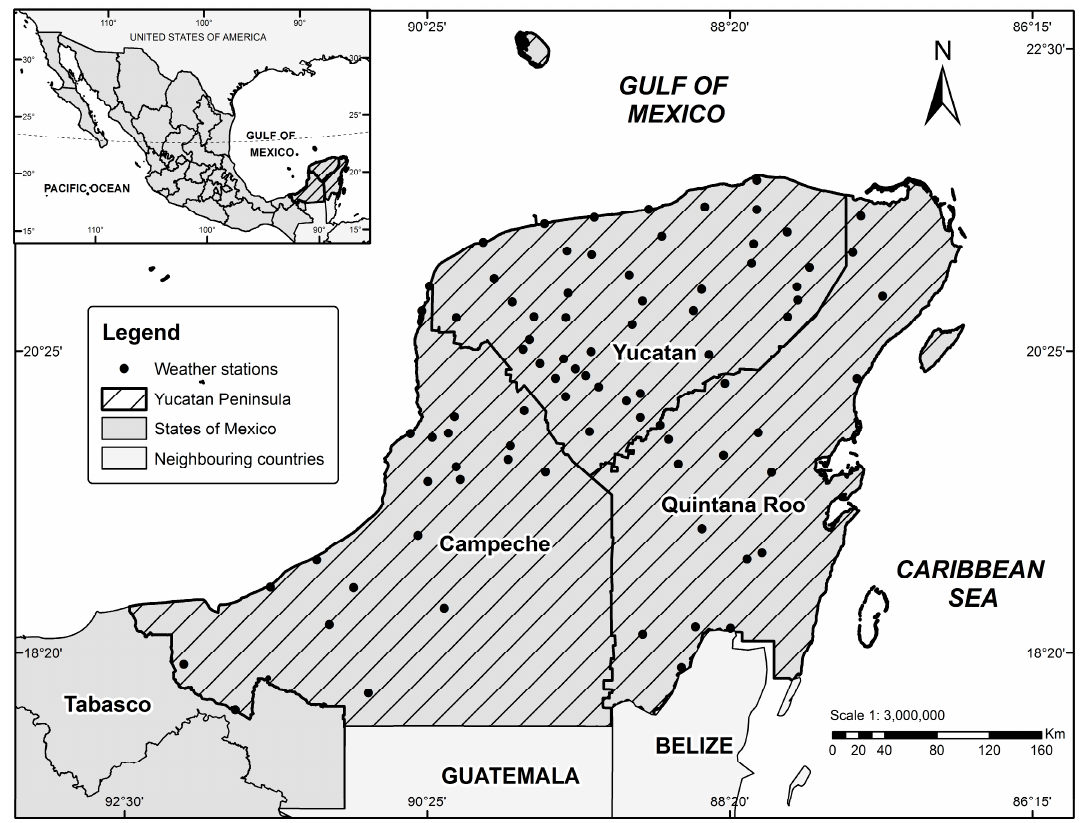
Figure 1. Study area, including the weather stations used for the analysis. Table 1. Extent of maize, per hectare yield, and total production per state for 2015, both rain-fed and irrigated. Source of data: Agricultural and Fisheries Information Service